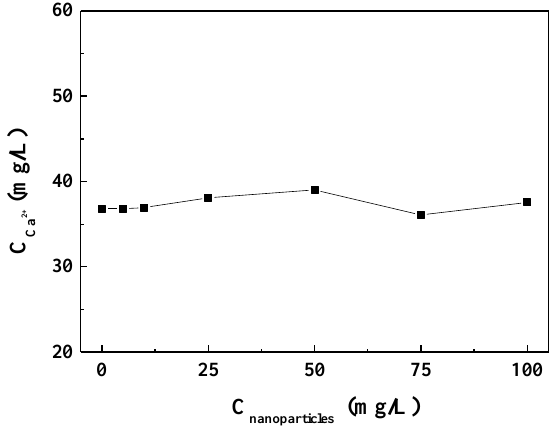
Figure 5. The concentration of residual calcium ions after experiments in the scale-forming solution containing different concentrations of carbon nanoparticles.